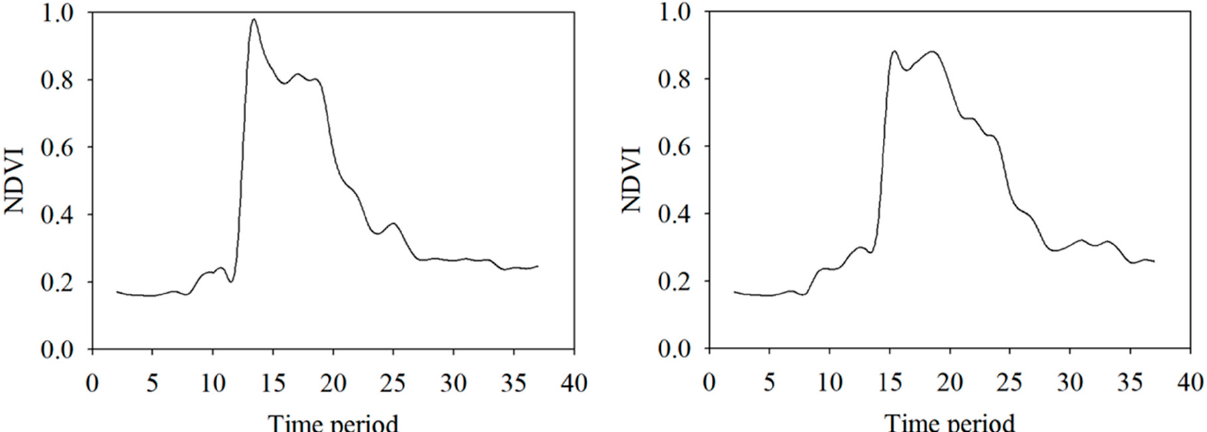
Figure 4. Illustration of augmentation for the vegetation index curve of the barley crop.